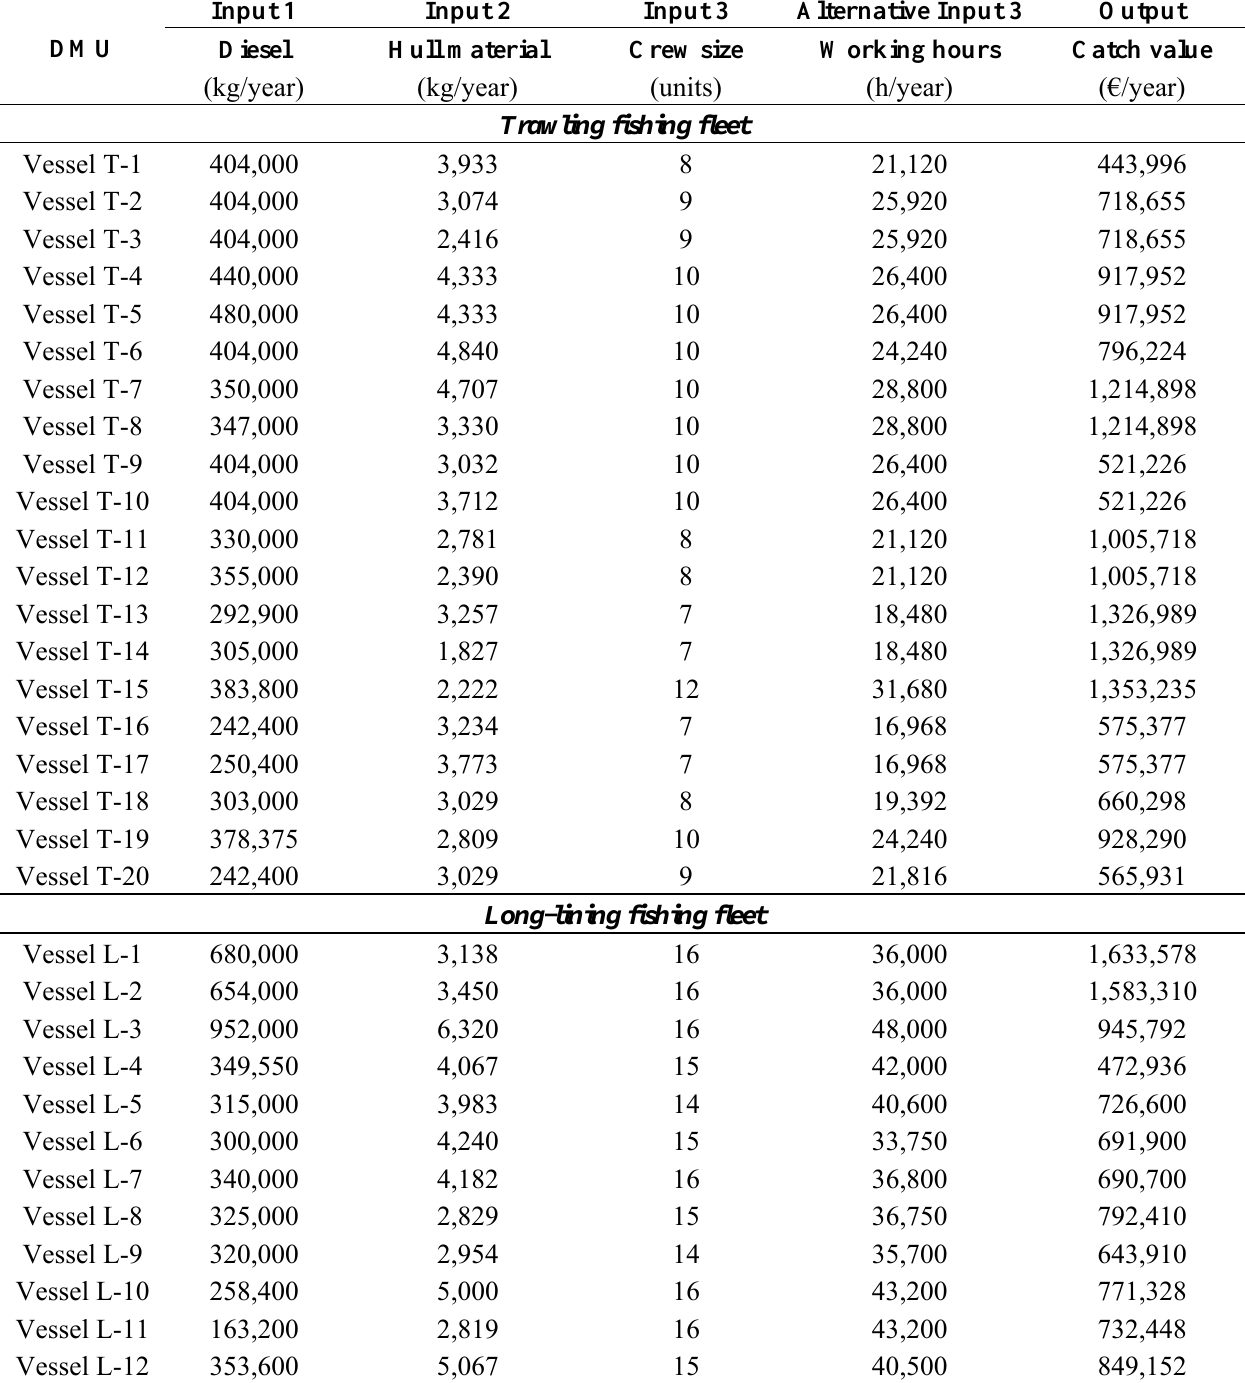
Table 1. DEA matrices for the illustrative case studies using the number of workers or working hours as an